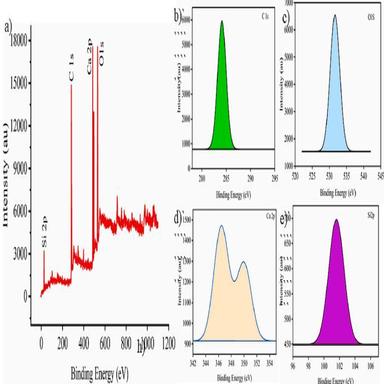
XPS of (a) survey scan with (b–e) individual elements of GG-CaO@SiO2 nanocomposite.